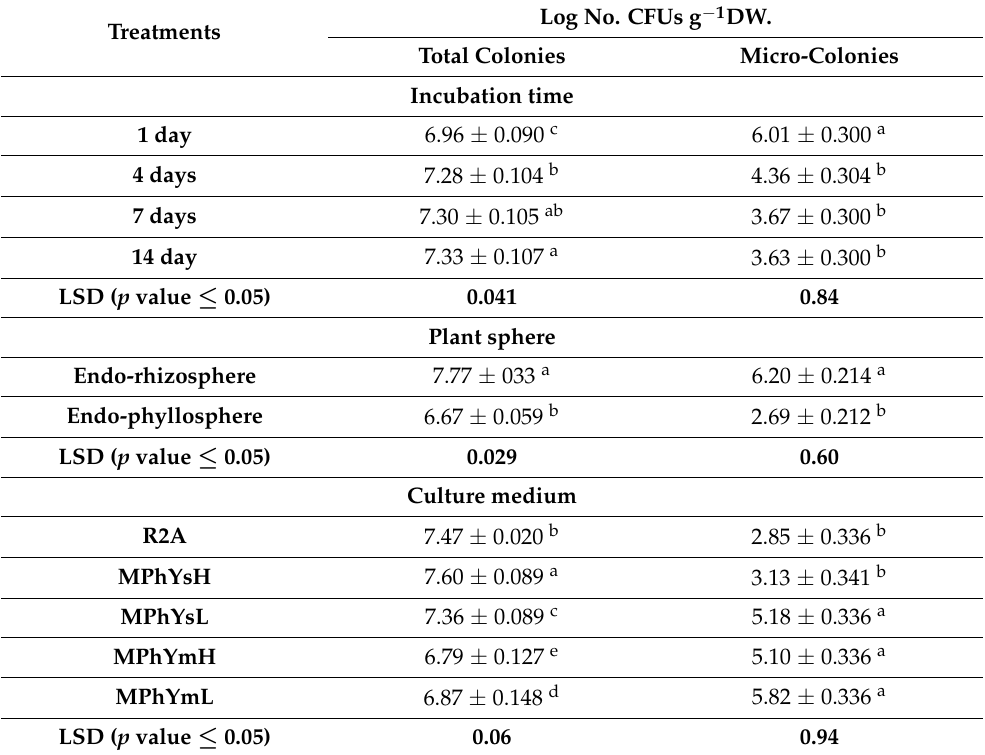
Table 1. One-way ANOVA analysis of log numbers of CFUs (data are log means ± standard error [SE], n = 5) of endophytes of the endo-rhizosphere and endo-phyllosphere of maize developed on all tested culture